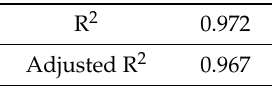
(Strain). Fatigue. 10